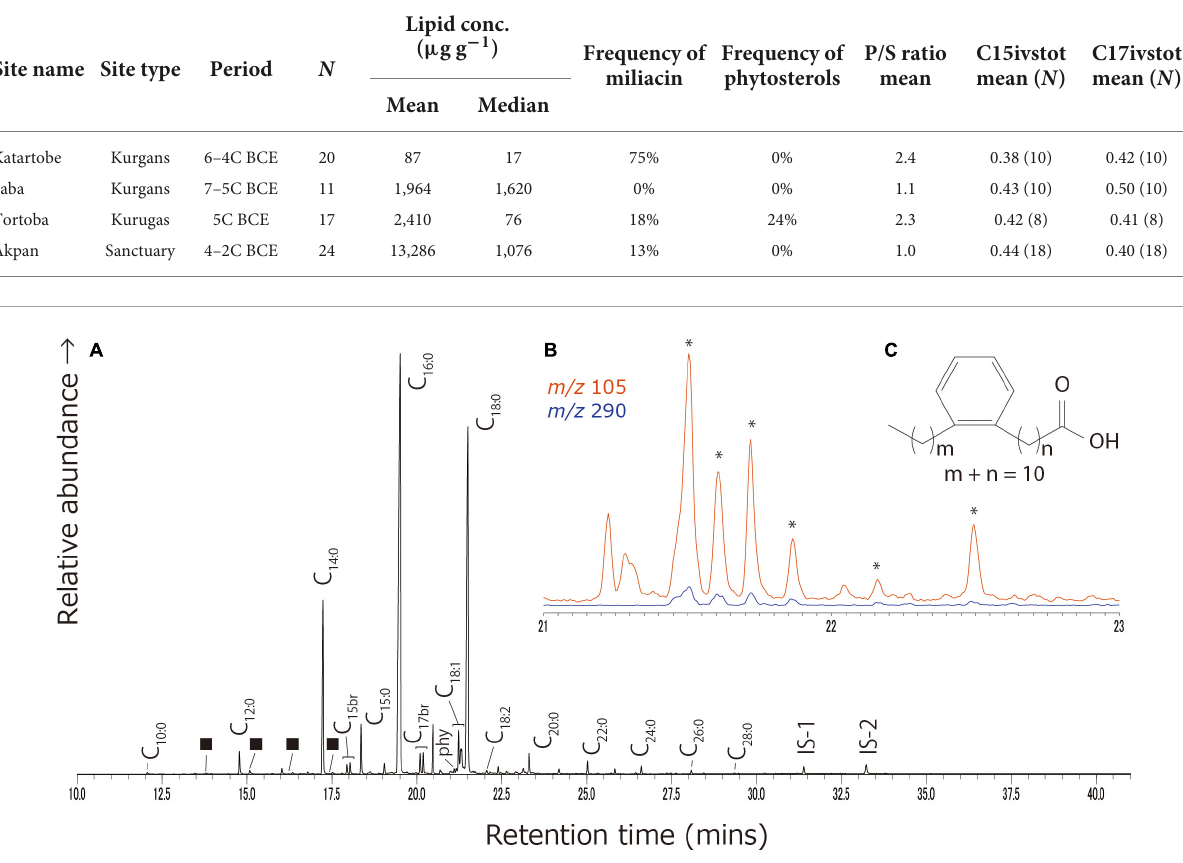
FIGURE2 Typical partial gas chromatogram of the Saba potsherd (SAB004IAE) lipid extract. (A) Partial total-ion chromatogram of the acidified methanol extracts. Peak identities–C x : y : saturated fatty acids with x carbon length and number of unsaturations y , (cid:4) : α , ω -dicarboxylic acids with carbon chain C 8 -C 11 . phy, phytanic acid; IS-1, n-tetratriacontane; IS-2, n-hexatriacontane. (B) The summed m/z 105 and 290 ion chromatogram shows the presence of ω -(o-alkylphenyl) alkanoic acids with 18 carbon atoms (*). (C) Chemical structure of